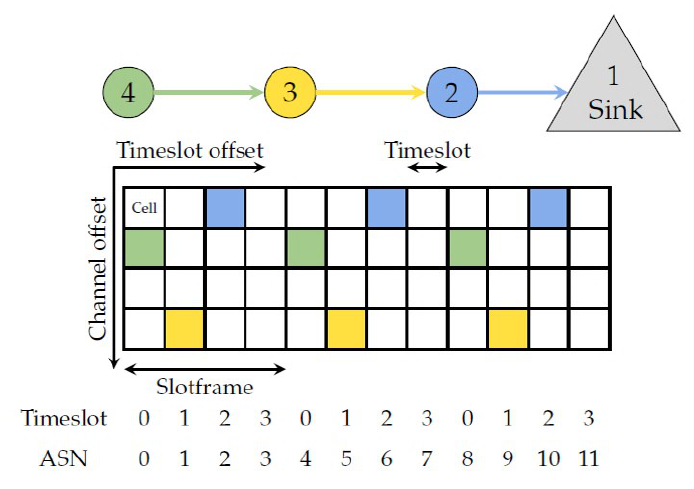
Figure 1. Simple wireless network topology with example TSCH